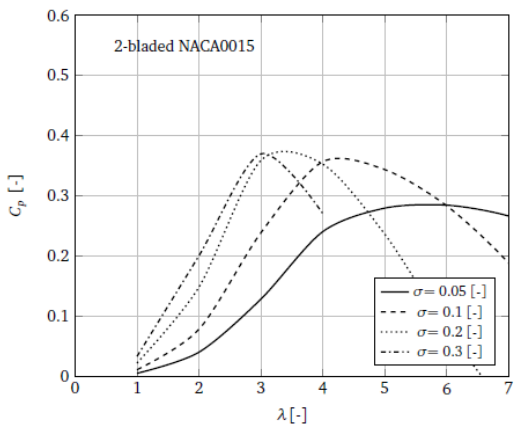
Figure 10. Effect of the tip speed ratio on the power coefficient at different solidities (AR = 5, D = 2 m, c = 0.1 m).